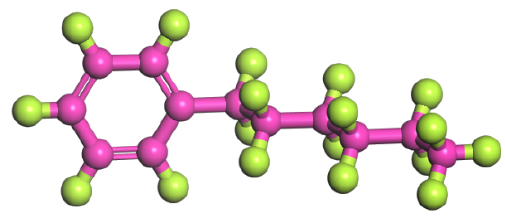
Figure 7. Molecular model of WEO.